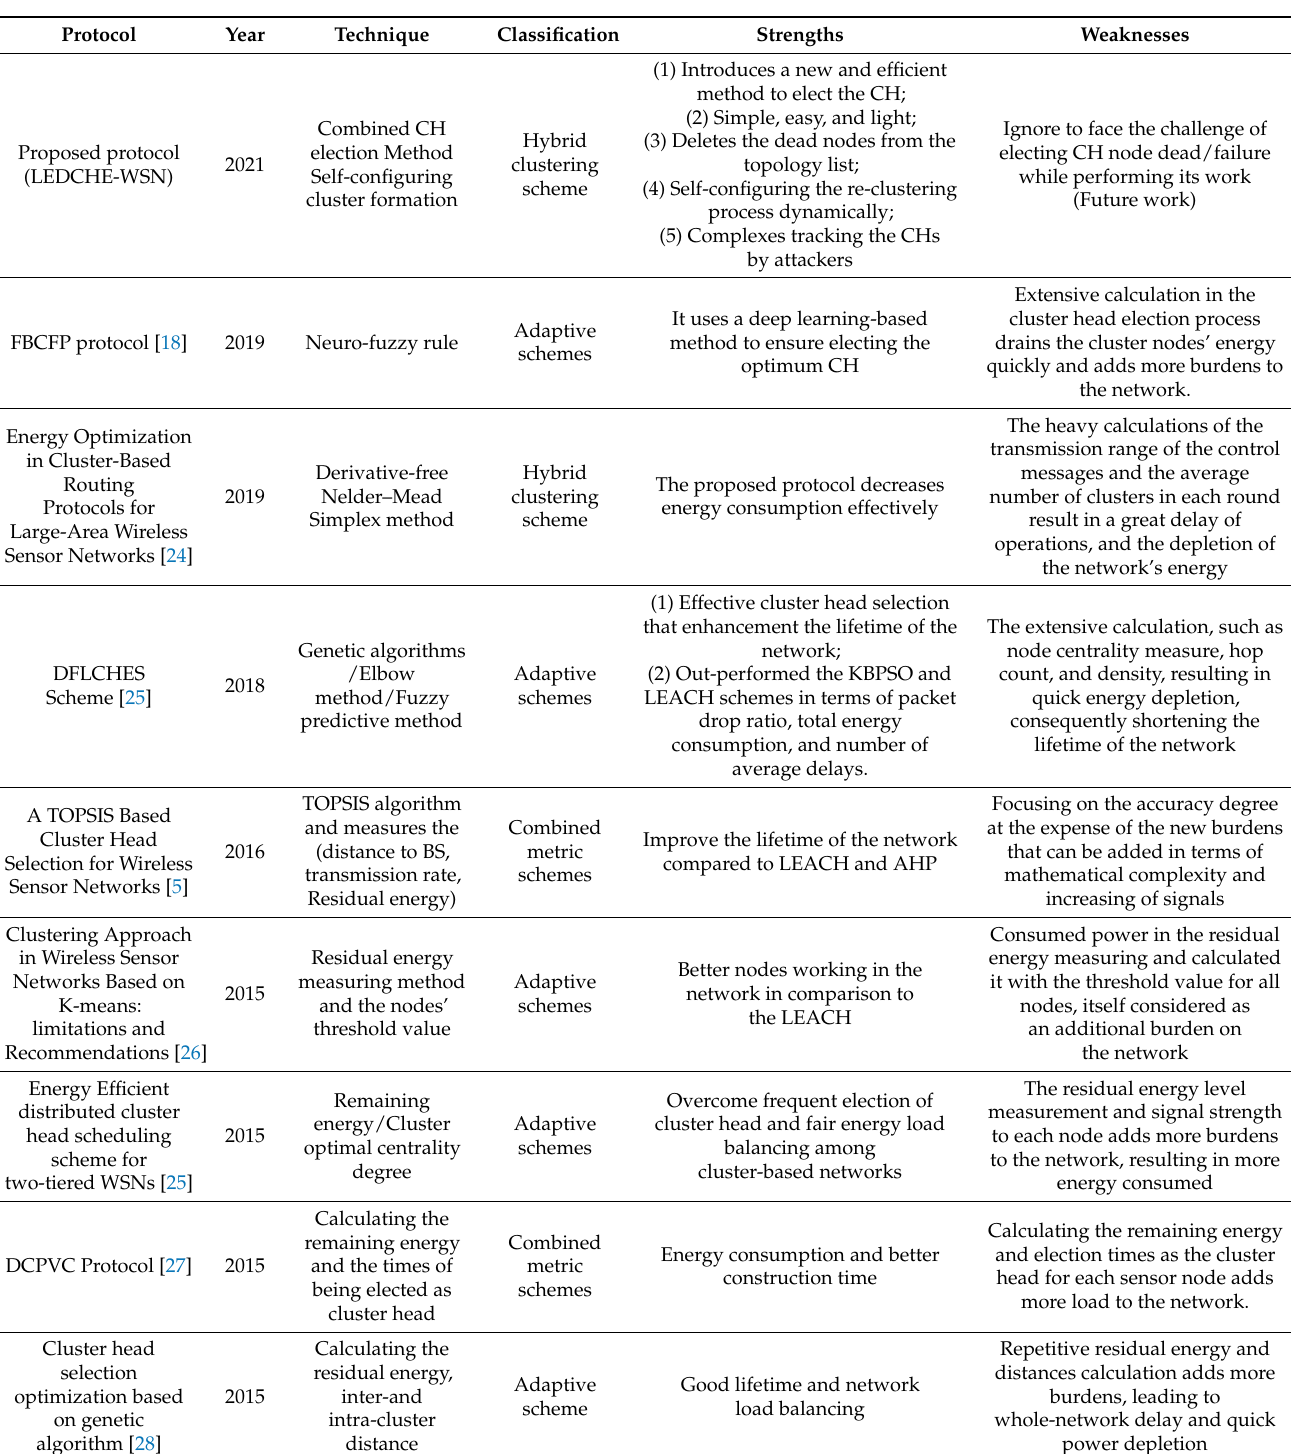
Table 1. Summary of related work for clustering